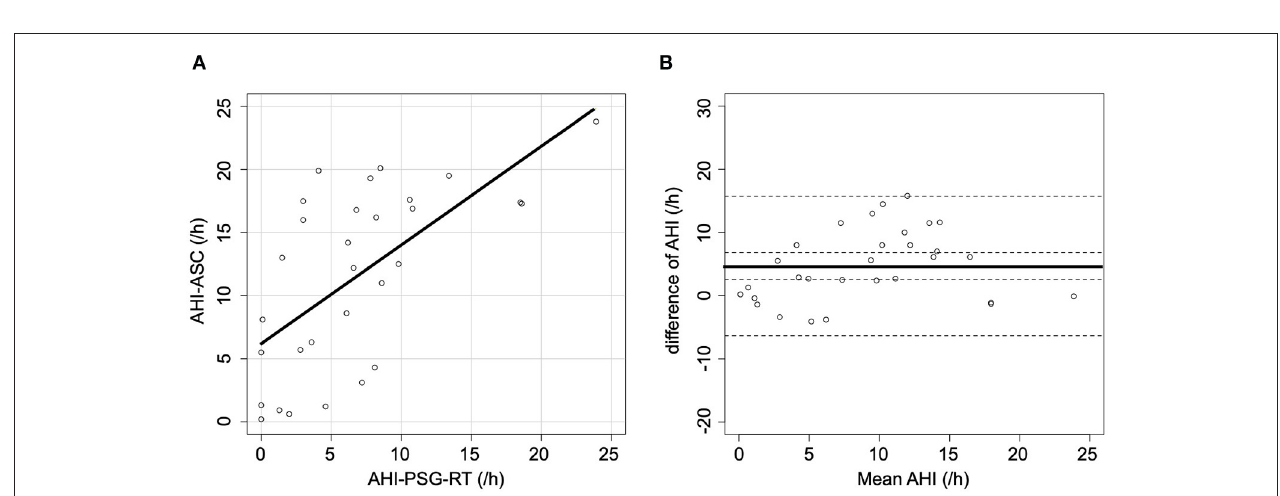
FIGURE 2 | Scatter and Bland-Altman plots comparing AHI-PSG-RT and AHI-ASC. (A) There was a moderate correlation between AHI-PSG-RT and AHI-ASC. (B) The Y-axis represents the difference between AHI-PSG-RT and AHI-ASC [(AHI-PSG-RT)–(AHI-ASC)]. The X-axis indicates the mean values. The solid line represents the mean difference, while the dashed lines represent the limit of agreement ( ± 2